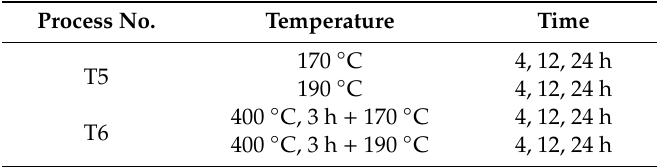
Table 2. Process of heat treatment.